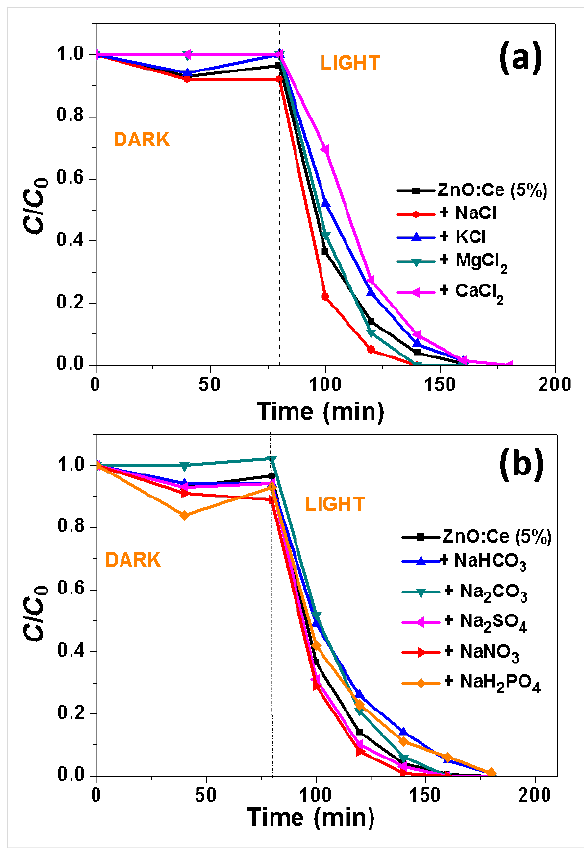
Figure 11: Effects of various salts on the photocatalytic efficiency of the ZnO:Ce rods used under solar light irradiation (Volume of solution, 30 mL; Orange II concentration, 10 mg/L; mass of catalyst, 30